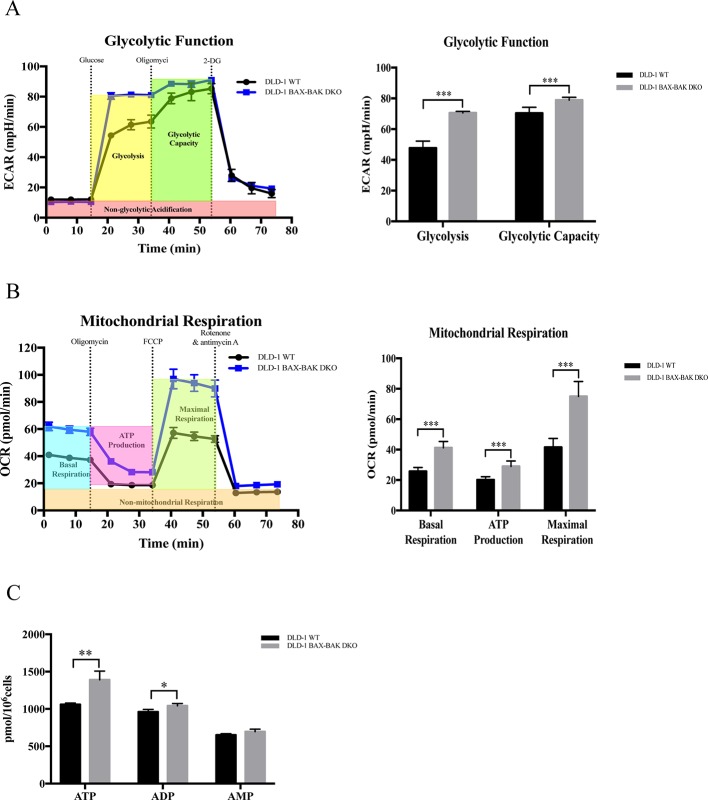
Capacity of glycolytic and mitochondrial respiration in DLD-1 WT and DLD-1 BAX–BAK DKO cells. (A) The glycolytic profile of DLD-1 WT and DLD-1 BAX–BAK DKO cells. The glycolytic function was measured by directly detecting the ECAR of cells. The compounds (glucose, oligomycin, 2-DG) were serially injected to measure the glycolysis and glycolytic capacity, respectively. (B) The mitochondrial respiration profile of DLD-1 WT and DLD-1 BAX–BAK DKO cells. Mitochondrial respiration test determines the key parameters of mitochondrial function by directly measuring the OCR of cells. The compounds (oligomycin, FCCP, and a mix of rotenone and antimycin A) were serially injected to measure the basal respiration, ATP production, and maximal respiration, respectively. (C) ATP production (pmol/106 cells) in DLD-1 WT and DLD-1 BAX–BAK DKO colon cancer cells. The data is represented as mean ± S.D. (n = 3). ***p < 0.001, **p < 0.01 and *p < 0.05 compared with DLD-1 WT cells, t-tests analysis.